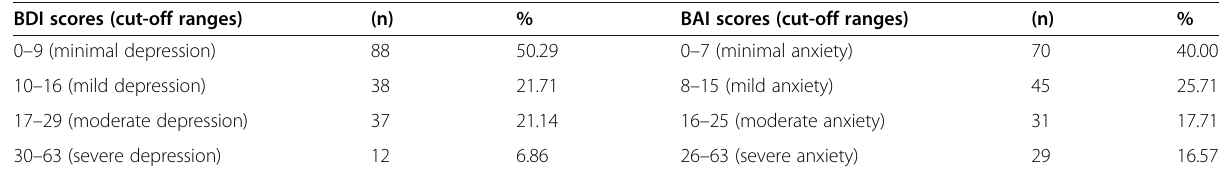
Table 2 Mean (± SD) total scores on the Beck inventories for depression (BDI) and anxiety (BAI) according to the relative cut-off ranges used to categorize individuals with minimal, mild, moderate, or severe depression or anxiety BDI scores (cut-off ranges)